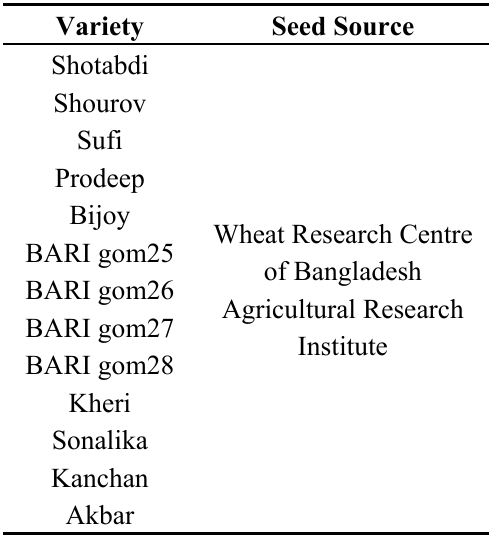
Table 4. List of 13 wheat varieties used for studying root hairs’ development and associated traits under PEG-treated hydroponic